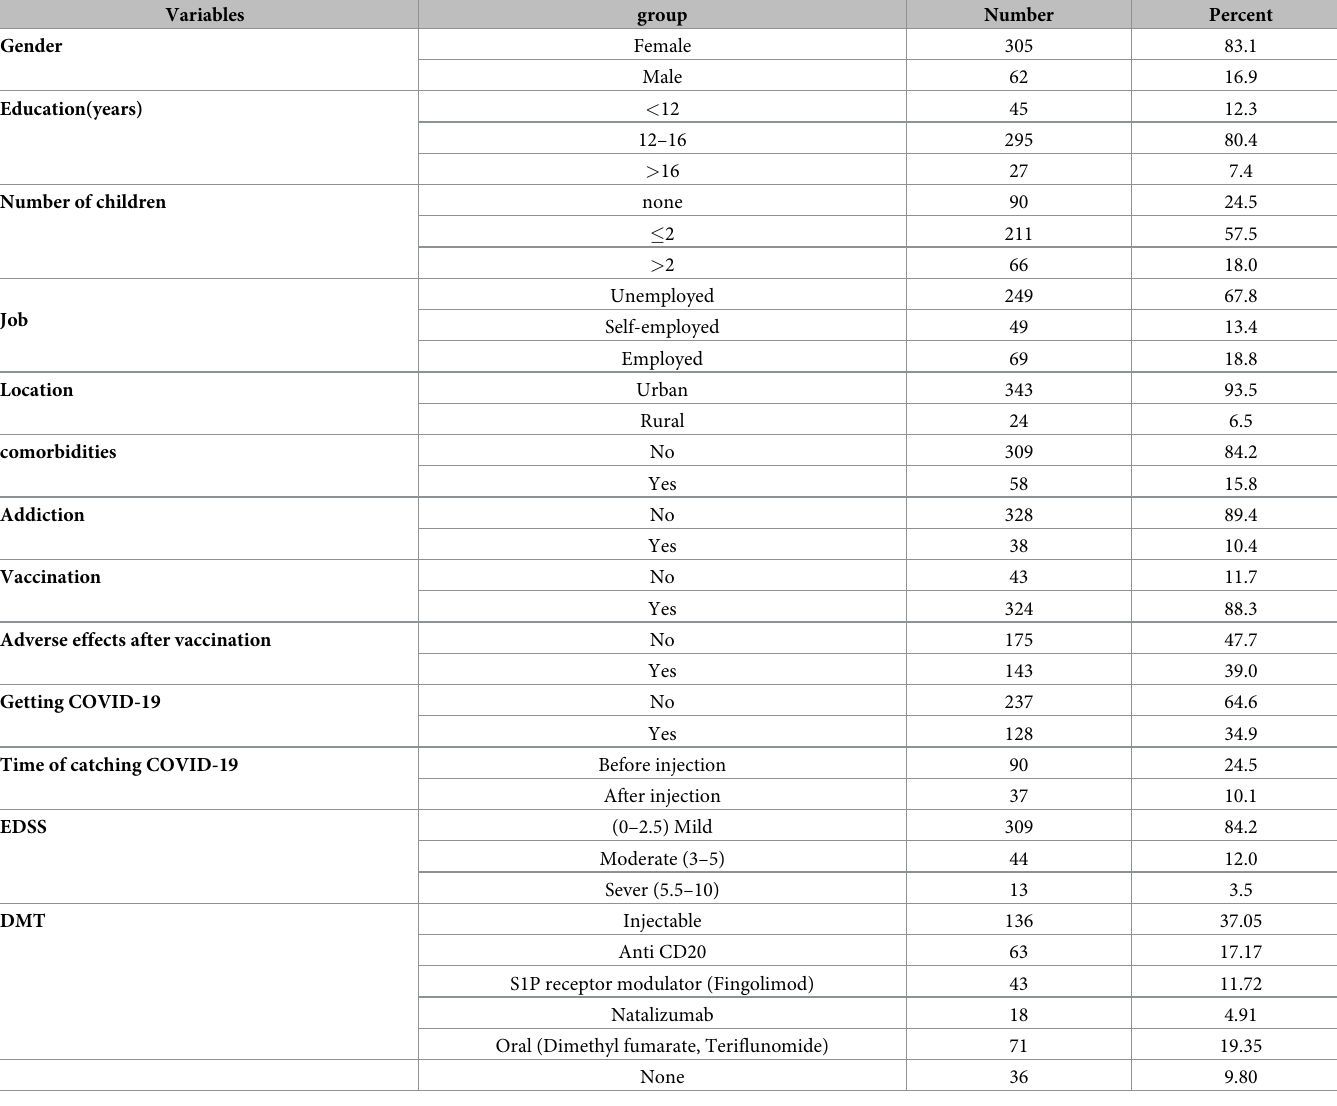
Table 1. Demographic characteristics (N =